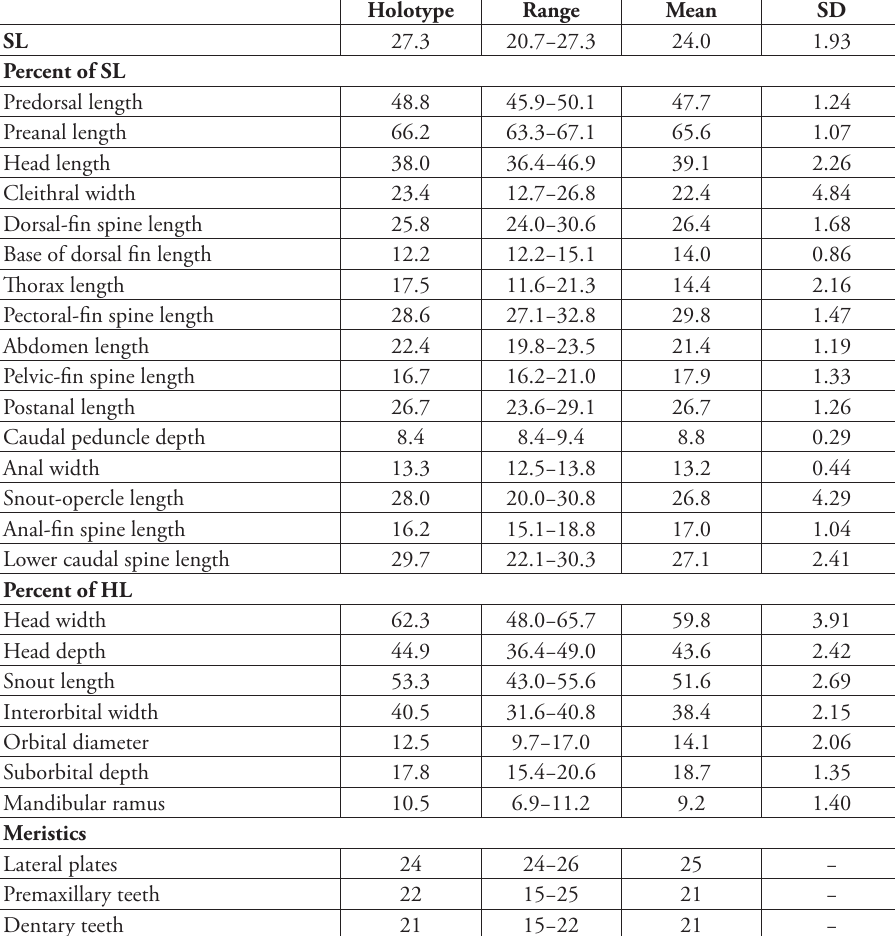
Table 1. Morphometric and meristic data for Parotocinclus dani (N =